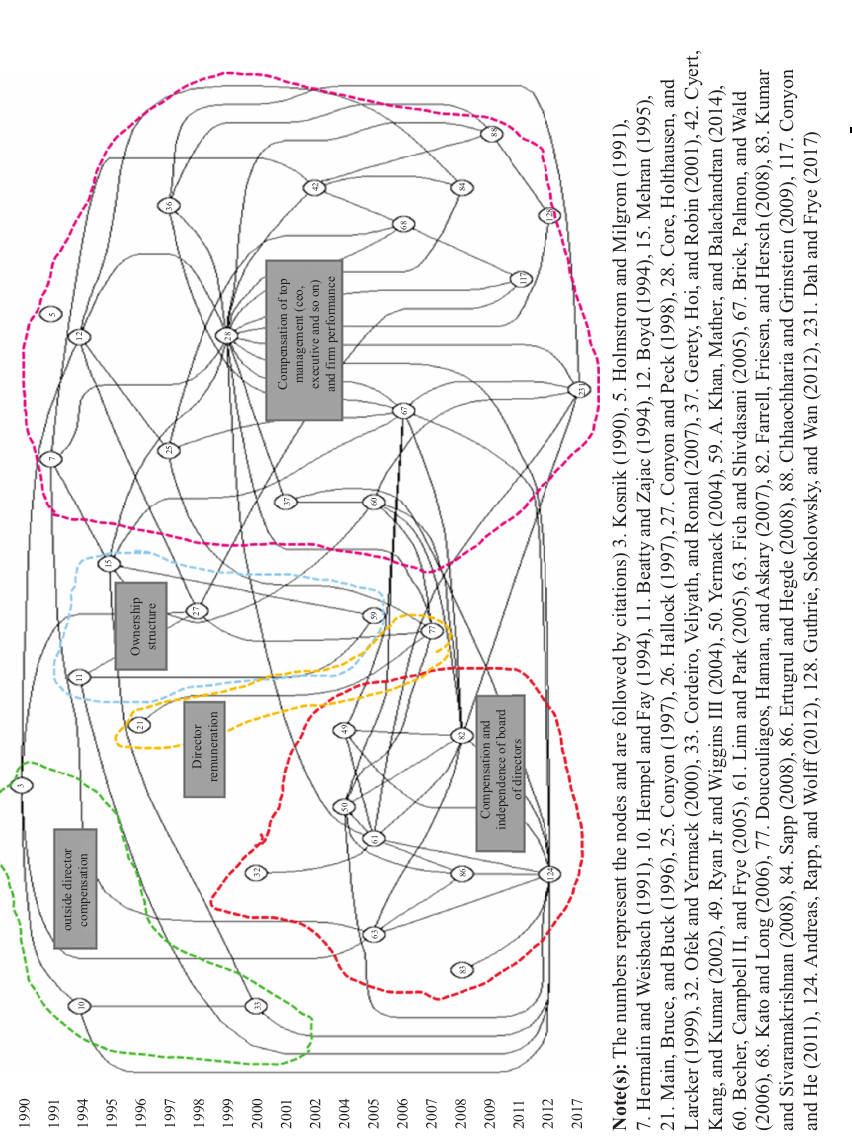
Figure 3. Citationmappingofthe most influential